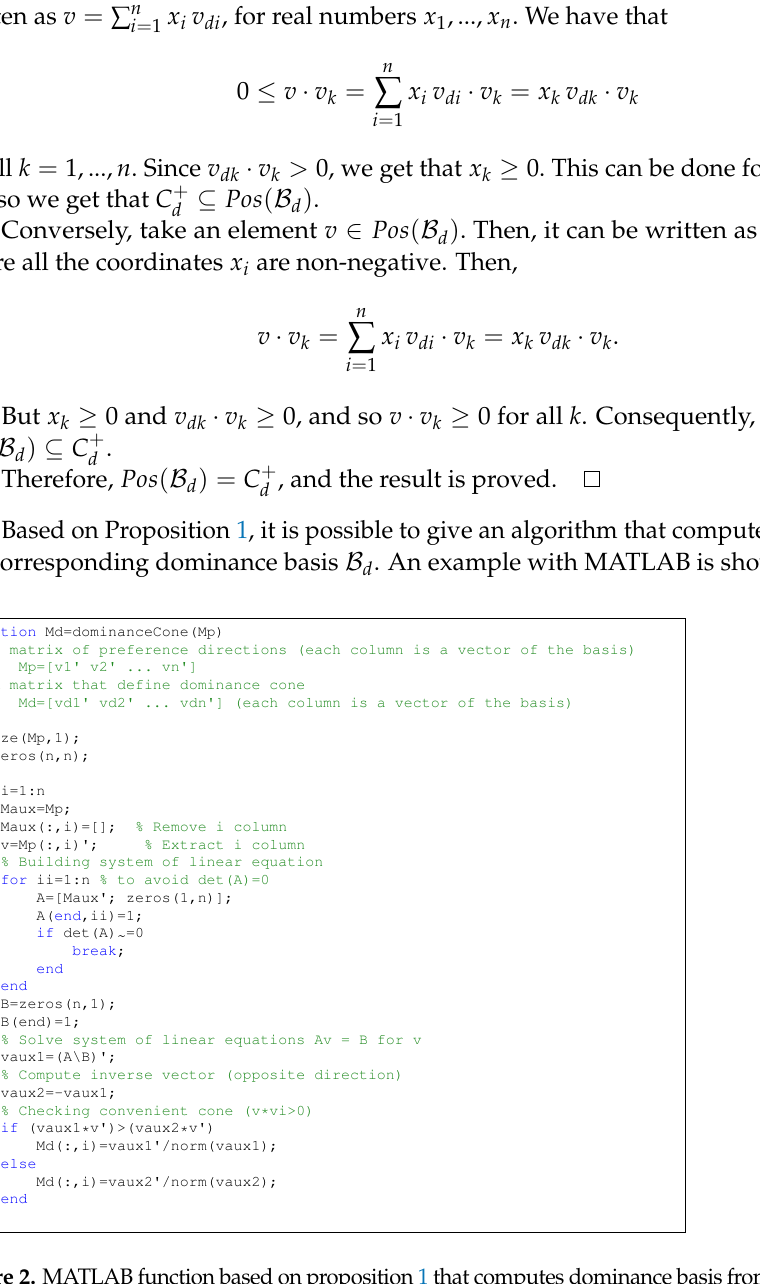
Figure 2. Matlab function based on proposition 3 that computes dominance basis from preference Figure 2. MATLAB function based on proposition 1 that computes dominance basis from preference basis.